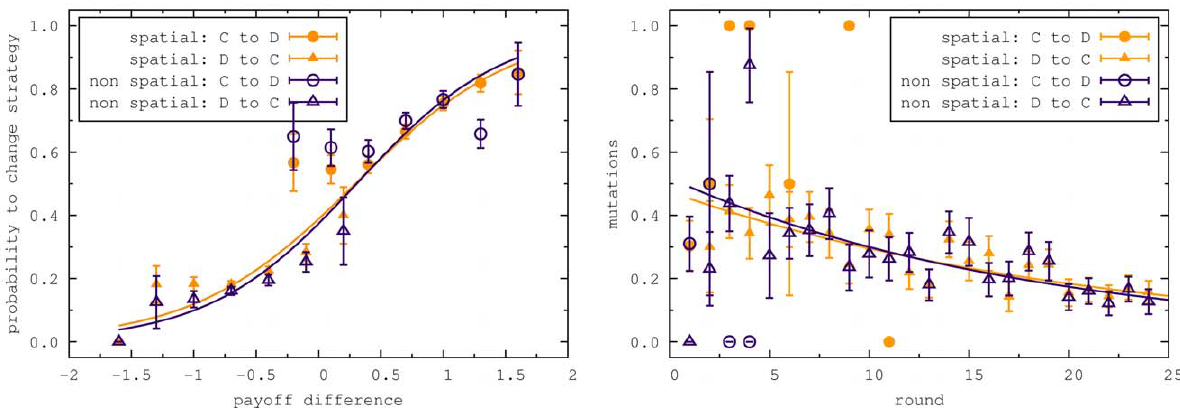
Figure 3. Probability of imitating depending on the payoff difference. Left: probability of switching to another strategy depending on the payoff differences for both the spatial and non spatial experiment. The payoff difference is between the focal player and the best player of the opposite strategy. The results are consistent with imitating the neighbors with higher payoffs. However this imitation is not unconditional, but the higher the payoff difference the larger is the probability of imitation. In addition, players might spontaneously switch their strategies even if they have no neighbors playing the other strategy, resembling mutations. Error bars are the standard deviations of a binomial distribution, ffiffiffiffiffiffiffiffiffiffiffiffiffiffiffiffiffiffiffiffiffiffiffiffiffiffiffiffiffiffiffiffiffiffiffiffiffiffiffiffiffi P { P C < D (1 C < D ) = n )